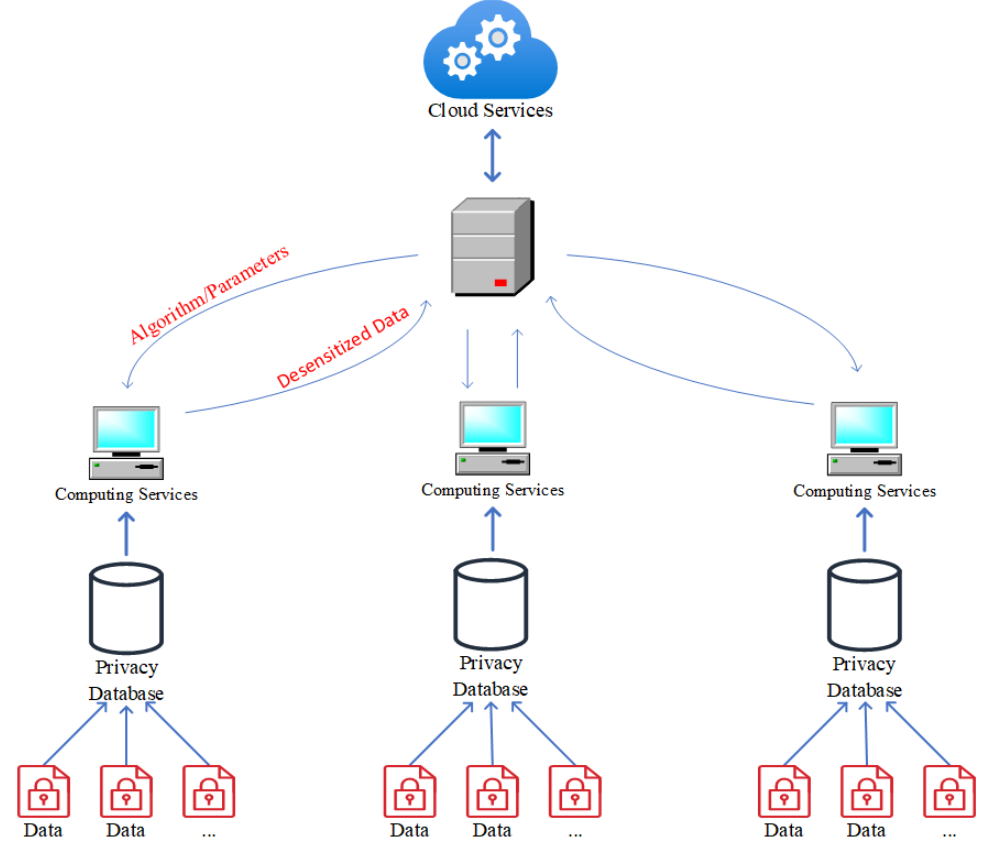
Figure 2. Federated learning model.